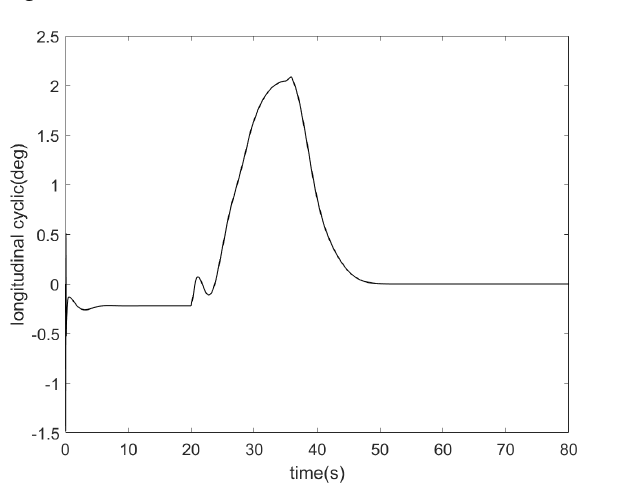
Figure 15. The time evolution of collective.